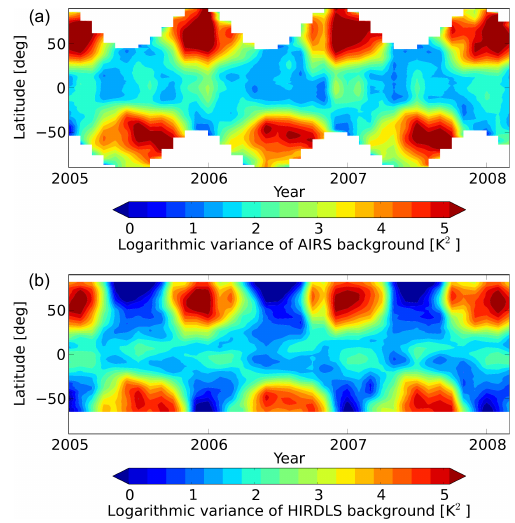
Figure 1. Time series of monthly mean temperature background variances for measurements between 2005 and 2008 at 42km alti- tude. (a) AIRS high-resolution retrieval. (b) HIRDLS operational retrieval. Data gaps in AIRS data (white areas) are related to the restriction to nighttime